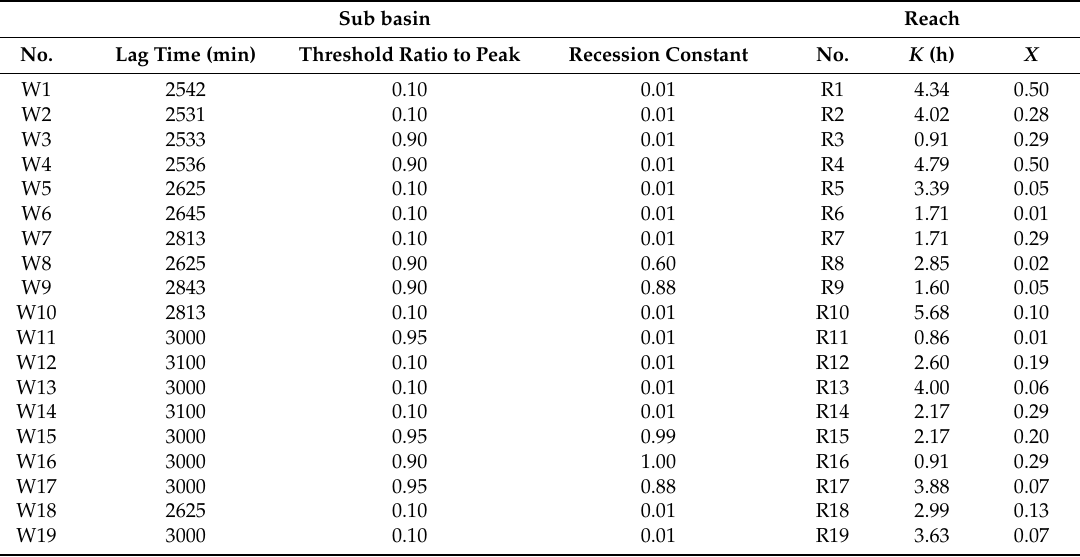
Table 5. Sub basin and reach parameters of the model without polder in the Qinhuai river basin. Sub basin Reach No. Threshold Ratio to